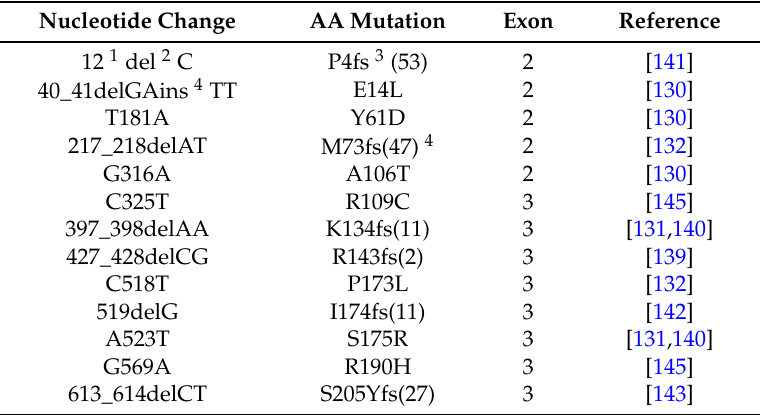
Table 1. Mutations in LRAT gene associated with retinal